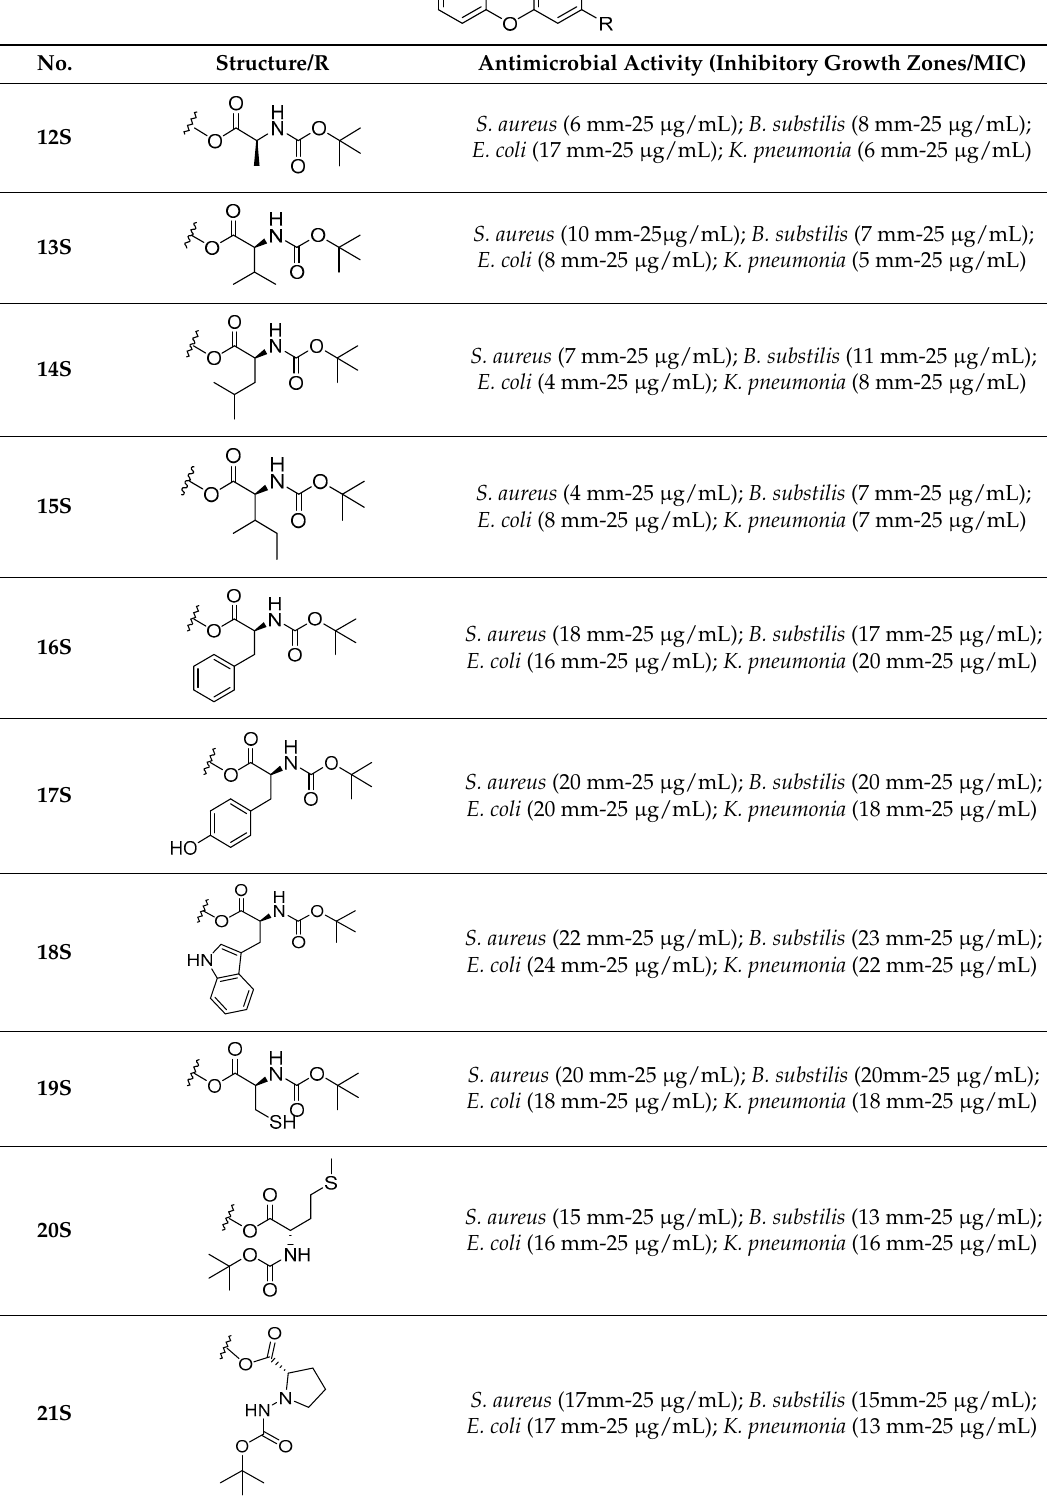
Table 9. Antimicrobial activity of amino acid xanthone derivatives.